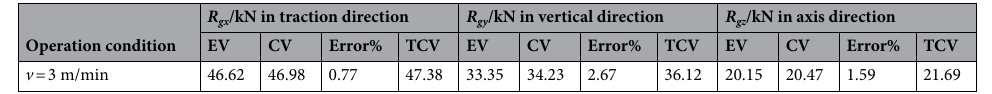
Table 5. Comparison of experimental values (EV) with corrected values (CV) for the three-directional loads of the drum.